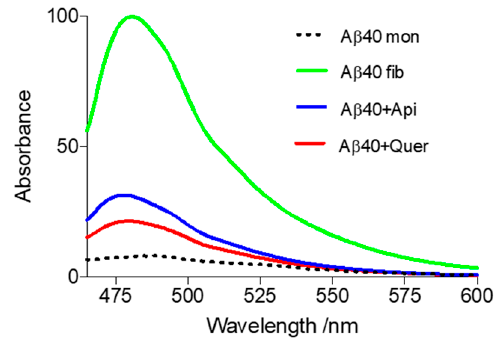
Figure 2. ThT fluorescence in the presence of A β 40: Effect of aggregation inhibitors. The samples were incubated at 37 ◦ C for 24 h and fluorescence emission spectra were recorded in the range 465—600 nm. Green spectrum: typical aggregation of A β ; black dotted spectrum: A β monomers incubated at 4 ◦ C (negative control); red spectrum: aggregation in the presence of quercetin; blue spectrum: aggregation in the presence of apigenin. Conditions: [Quercetin/Apigenin] = 20 µ M; [A β 40] = 20 µ M. The assays were performed in triplicates, and SD values <5% were obtained in all cases (not shown for the sake of clarity).